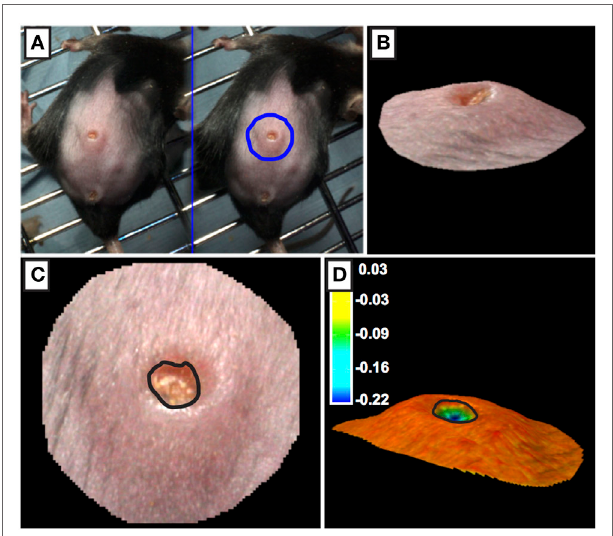
FIgURe 3 | Processing of 3D images of wounds. (A,B) The outer periphery of the wound site was outlined using the circle function with the circle diameter was approximately twice the diameter of the wound. (C,d) The edge of the wound (marked by black line) was calculated using topographical criteria using QuantiCare Dermapix Pro software and is shown in normal view (C) and pseudo-colored contour view (d) Pseudo-colored scale in microns.